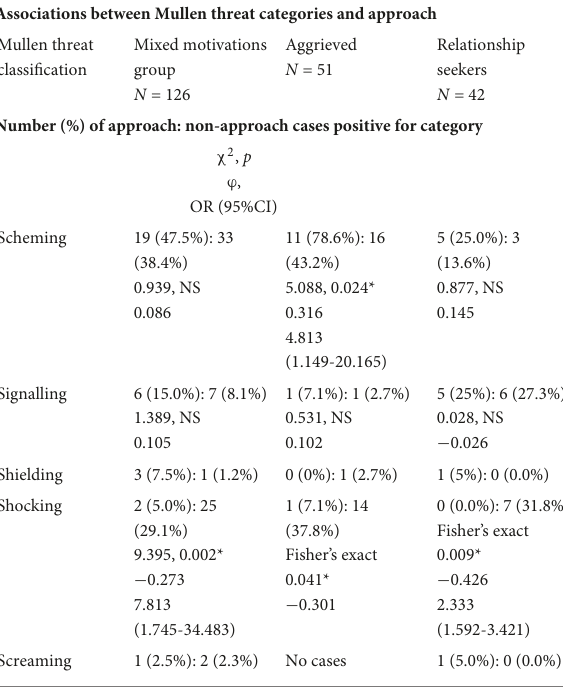
TABLE 4 Association between numbers of threats and approach. Association between numbers of threats and approach